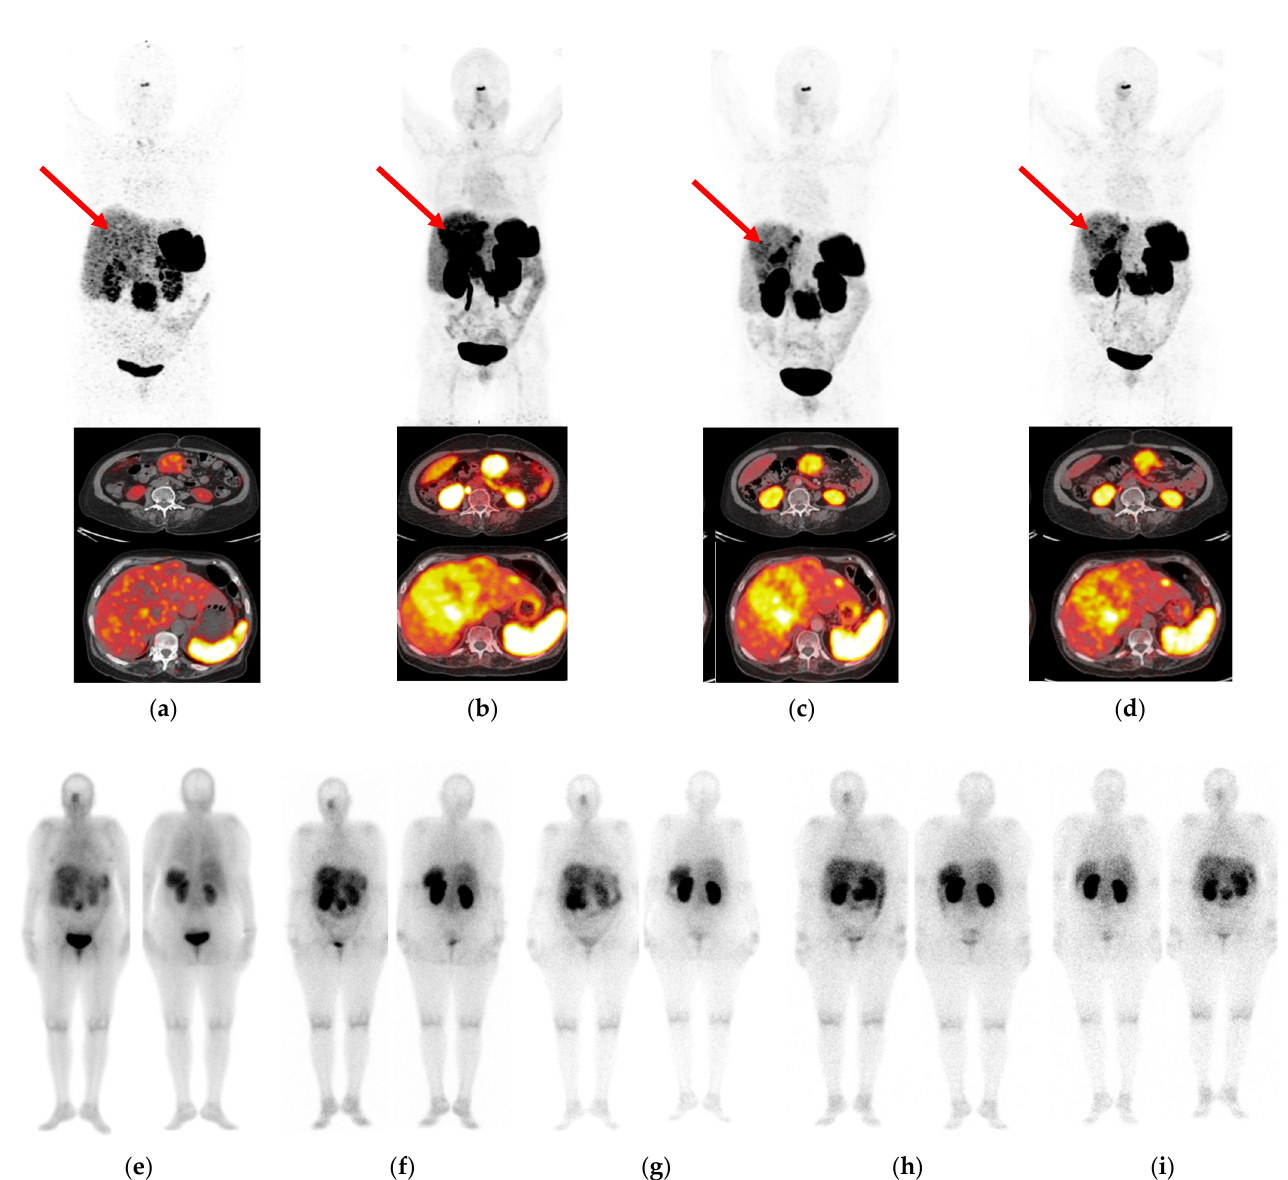
Figure 6. Correlation of PET/CT imaging ( a – d ) with SPECT/CT imaging ( e – i ) in a 68 ‐ year ‐ old female patient with a stomach NET with multiple lymph node and liver metastases. ( a ) Mild to negligible radiotracer concentration in pathological lesions on PET/CT with [ 68 Ga]Ga ‐ DOTA ‐ NOC at 1 h pi (reference) vs. PET/CT with [ 68 Ga]Ga ‐ DATA 5m ‐ LM4 at ( b ) 10 min pi, ( c ) 1 h pi and ( d ) 3 h pi, including whole ‐ body and transaxial views. As indicated by the red arrows, mild to negligible uptake was displayed by [ 68 Ga]Ga ‐ DOTA ‐ NOC in the liver metastases, whereas the uptake of [ 68 Ga]Ga ‐ DATA 5m ‐ LM4 was notably superior. The same patient was selected for sequential SPECT/CT imaging with [ 177 Lu]Lu ‐ AAZTA 5 ‐ LM4 at ( e ) 4 h, ( f ) 17 h, ( g ) 24 h, ( h ) 48 h and ( i ) 72 h pi (anterior/posterior views included for each time point).